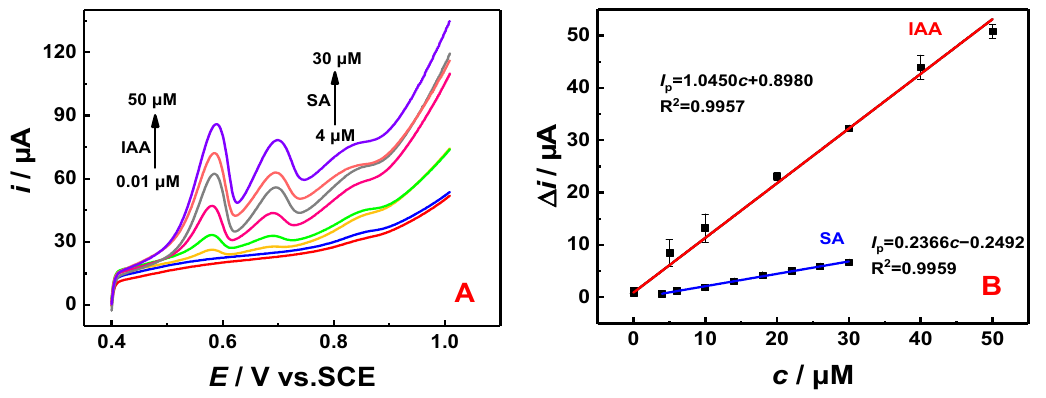
0.9957), and the detection limit ( S/N = 3) was 0.0086 μ M. The linear relationship of SA in the range of 4–30 μ M was I p ( μ A) = 0.2366 c ( μ mol/L) − 0.2492 (R 2 = 0.9959), and the detection limit was 0.7 μ M ( S/N = 3). As shown in Table 2. The detection limit is superior to the simultaneous detection of IAA and SA at typical modified electrodes.